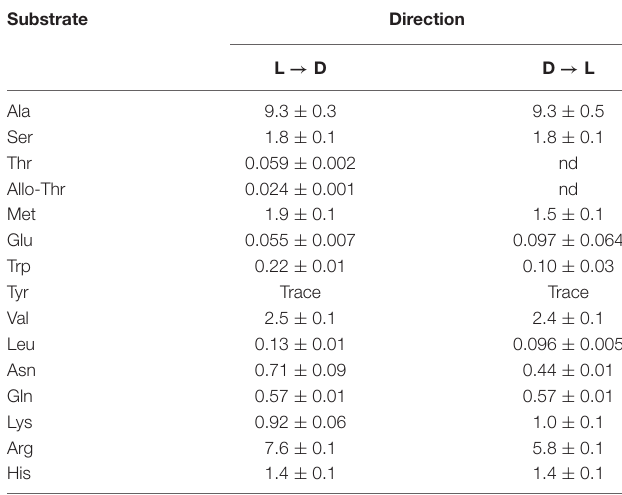
TABLE 2 | Substrate specificity of racemase reaction of WT enzyme.